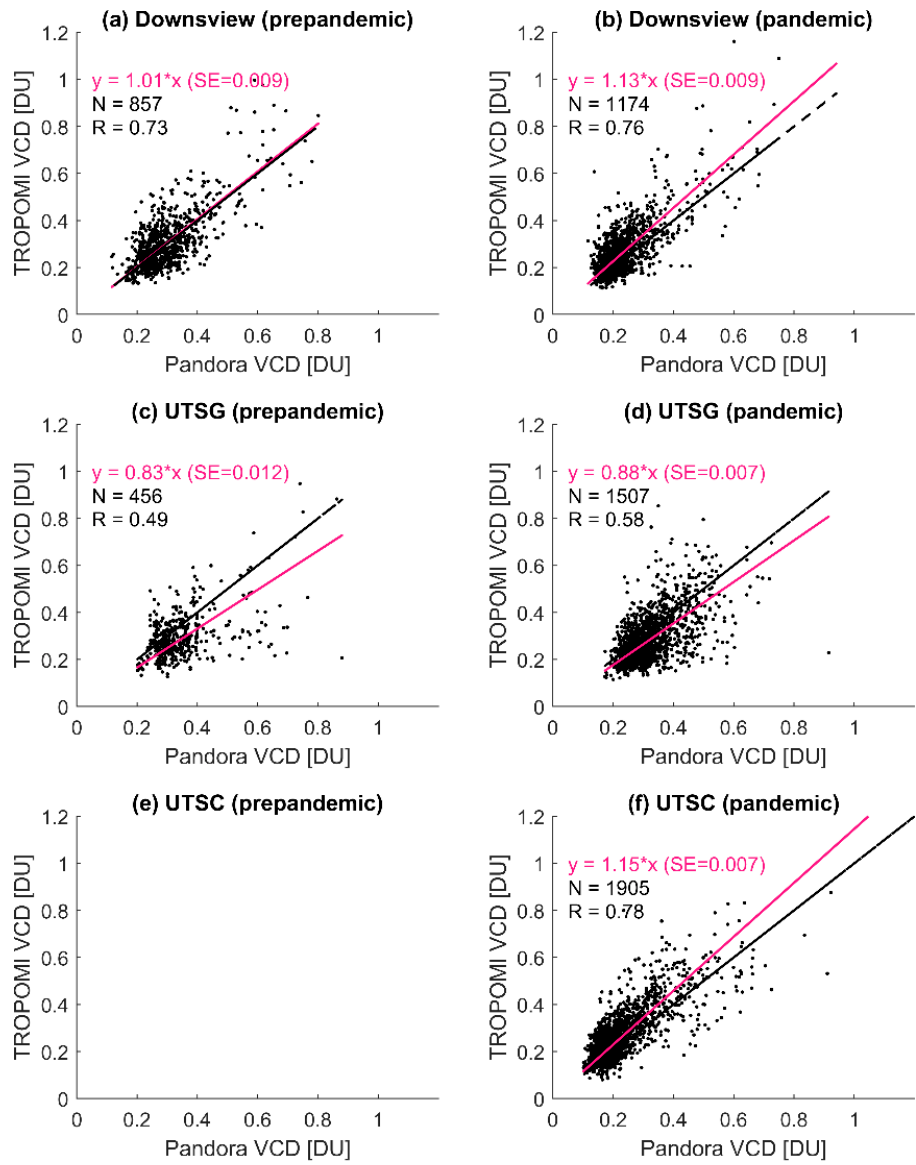
Figure 10. TROPOMI vs. Pandora NO 2 total column (VCD) measurements at Downsview, UTSG, and UTSC, using data from before the pandemic ( a , c , e ) and since pandemic ( b , d , f ). The magenta line is the linear fit with intercept set to 0 (fitting result and standard error are shown on each plot), and the black line is the one-to-one line. Pandora measurements taken within ± 1 h around the TROPOMI overpass time were used (observations from 15 March to 15 September for each year).